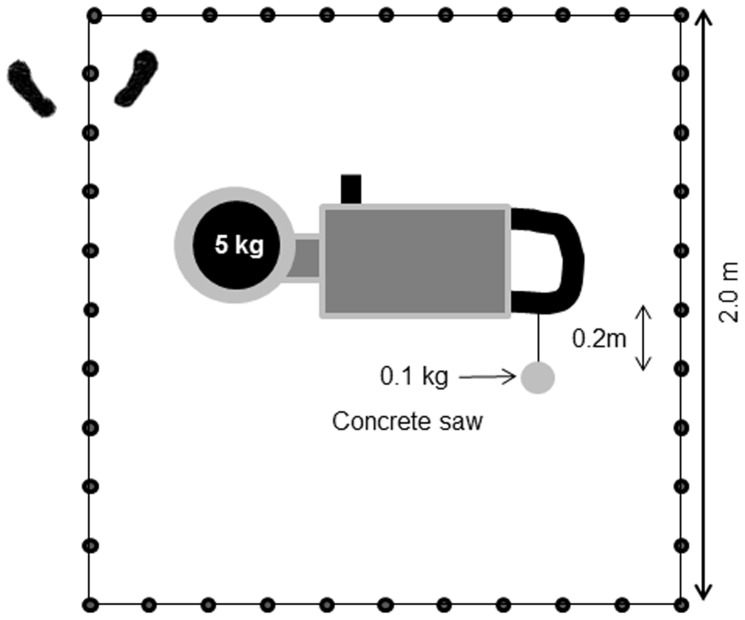
Schematic view of thecutting holes in the roof for fire gas ventilation work task.Subjects moved backwards along the markers, holding the concrete saw.